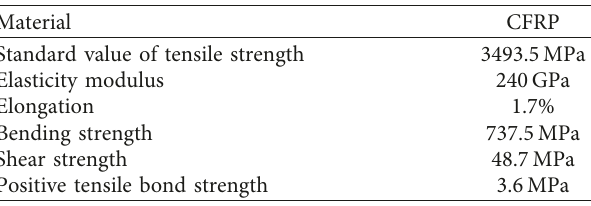
Figure 3: Reinforcing scheme of CFRP (unit: mm). Table 3: Mechanical properties of CFRP.